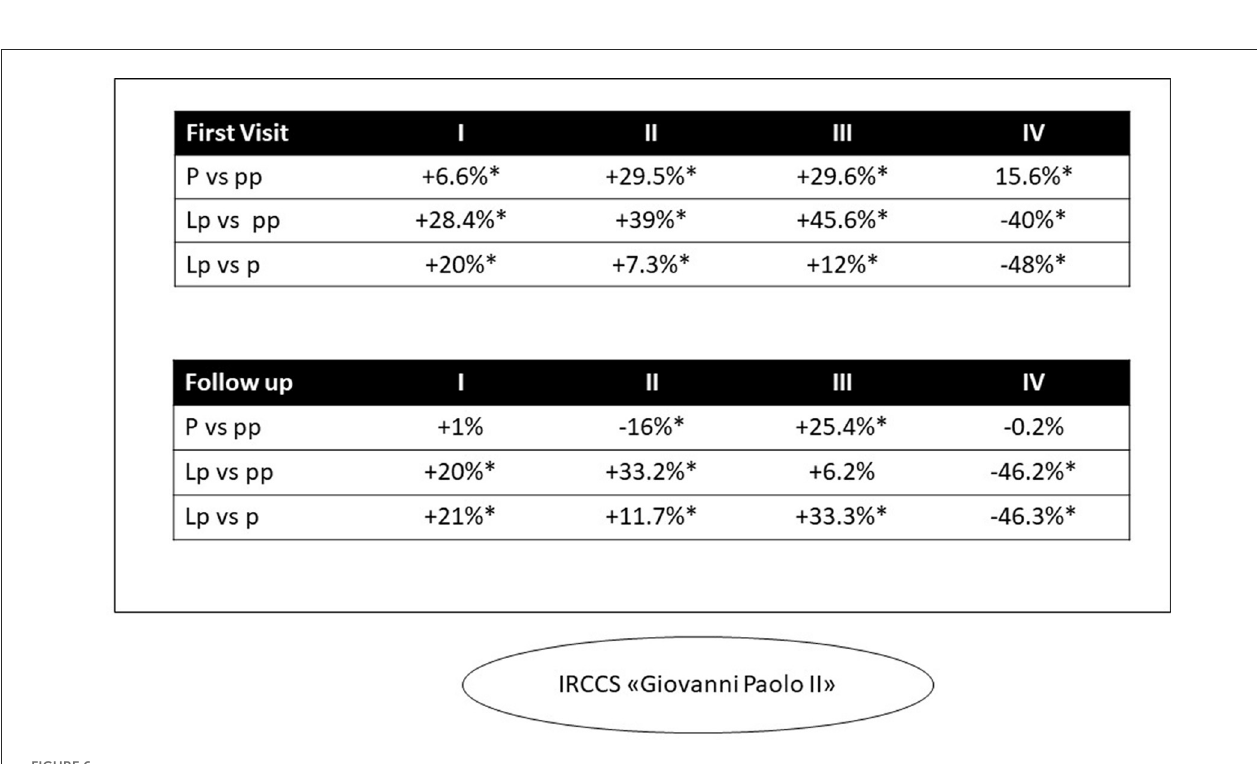
in the total volume of first-time visits to lp (Figure 3), but this was not statistically significant for the entire year. By comparing data from periods at the same Rt, that is 1.3 (second quarter of 2020 and